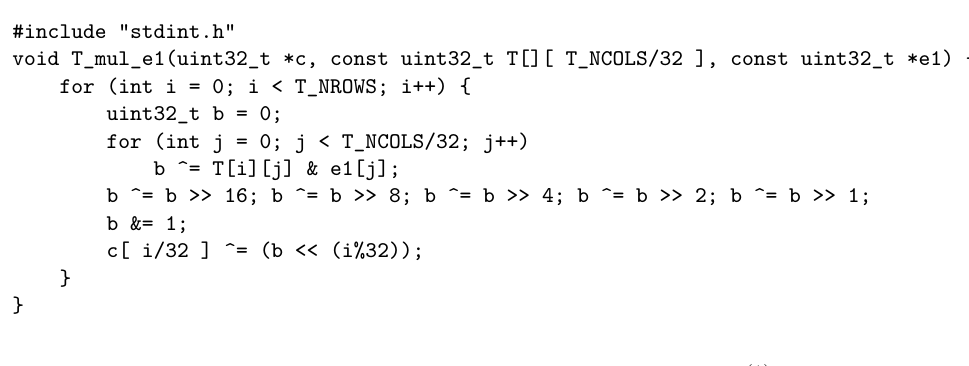
Figure 2: A simple C function for computing Te (1) .